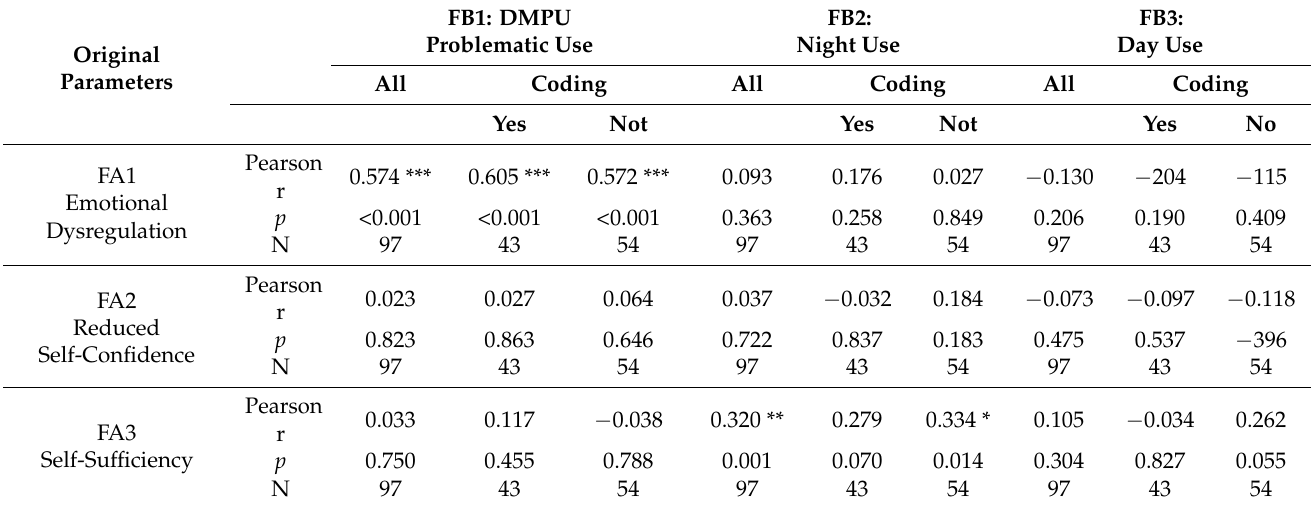
Table 11. Correlations between Psychological Factors and Behavioral Factors.